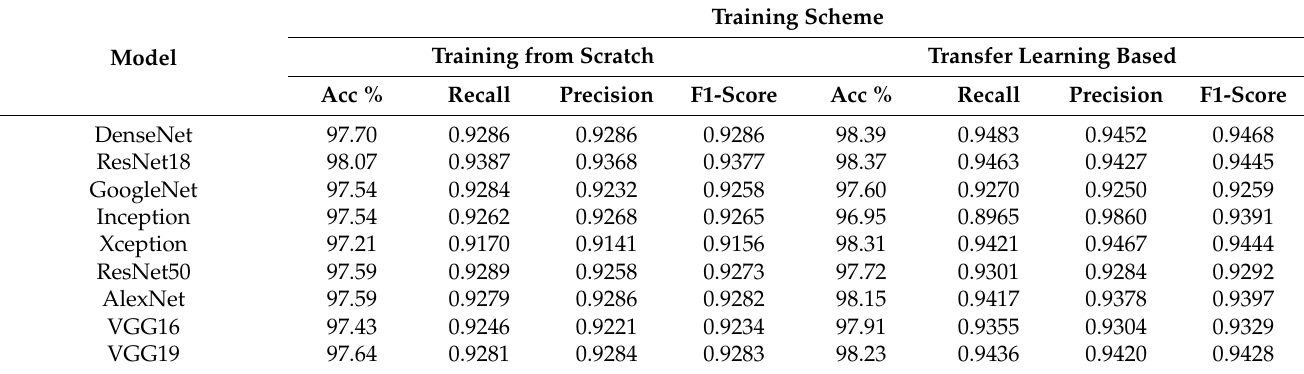
Table 7. Deep feature extracted from customized CNN models and SVM classification (DFS-MC). Training Scheme Training from Scratch Transfer Learning Model